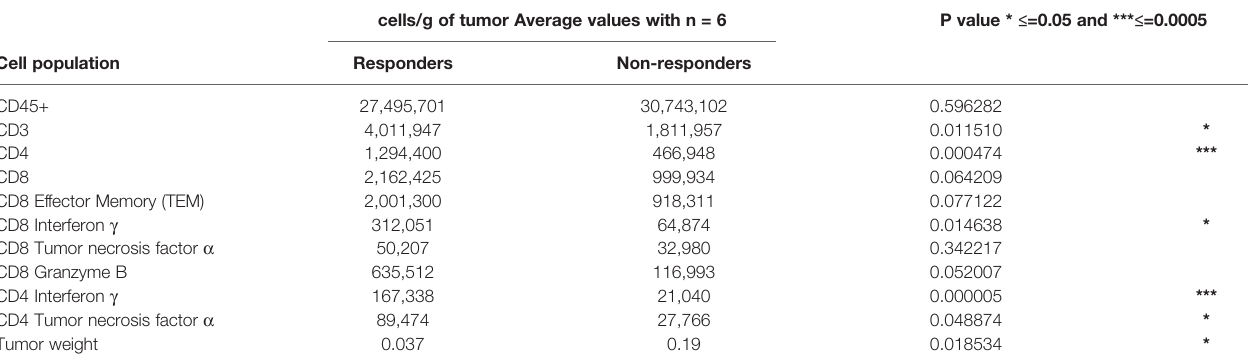
Different cell populationswere compared forcell numbers pergram oftumorbetween respondersand non-responders. p valuesfromStudent ’ st-test aredenoted tosignifythestatistical differences between responders and non-responders. p-*=<0.05,